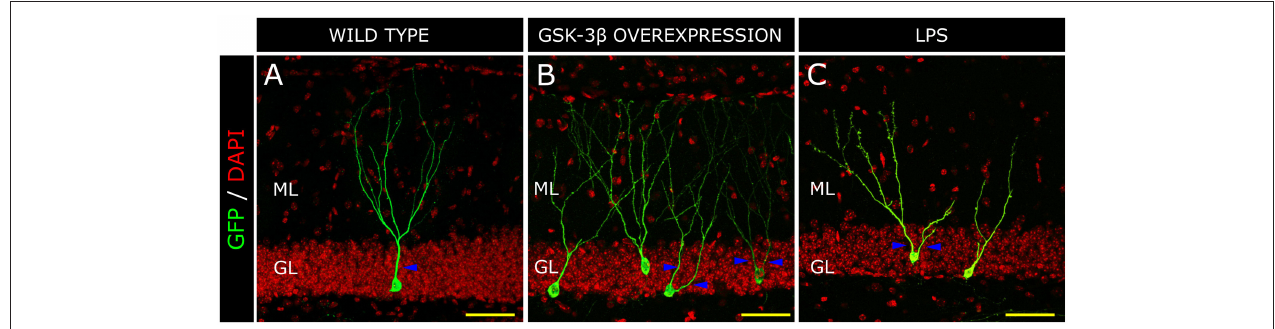
FIGURE 3 | Morphological alterations in a model of Alzheimer disease (AD) and inflammation. Retrovirus-labeled newborn neurons from control mice present one apical primary dendrite (blue triangles) and the dendritic tree resembles a “Y-shape” in the control mouse (A) . In contrast, in GSK-3 β -overexpressing mice (a murine model of AD), cells acquire a “V-shape” morphology, characterized by the presence of several apical dendrites and atrophy of the distal branching of the dendritic tree (B) . In a model of brain inflammation induced by the peripheral infusion of LPS, newborn granule neurons also acquire a “V-shape” and show increased branching in the proximal domain of the dendritic tree, whereas distal domains appear to be atrophied (C) . H, Hilus; GL, Granule cell layer; ML, Molecular layer. Yellow scale bar: 50 µ m.